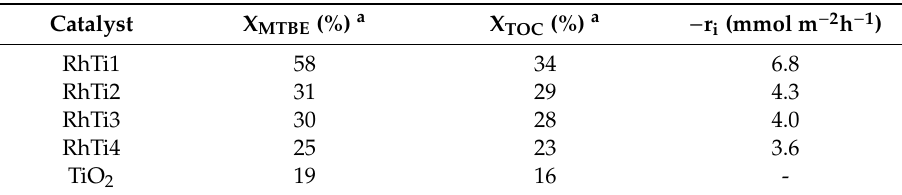
a Calculated at 60 min of